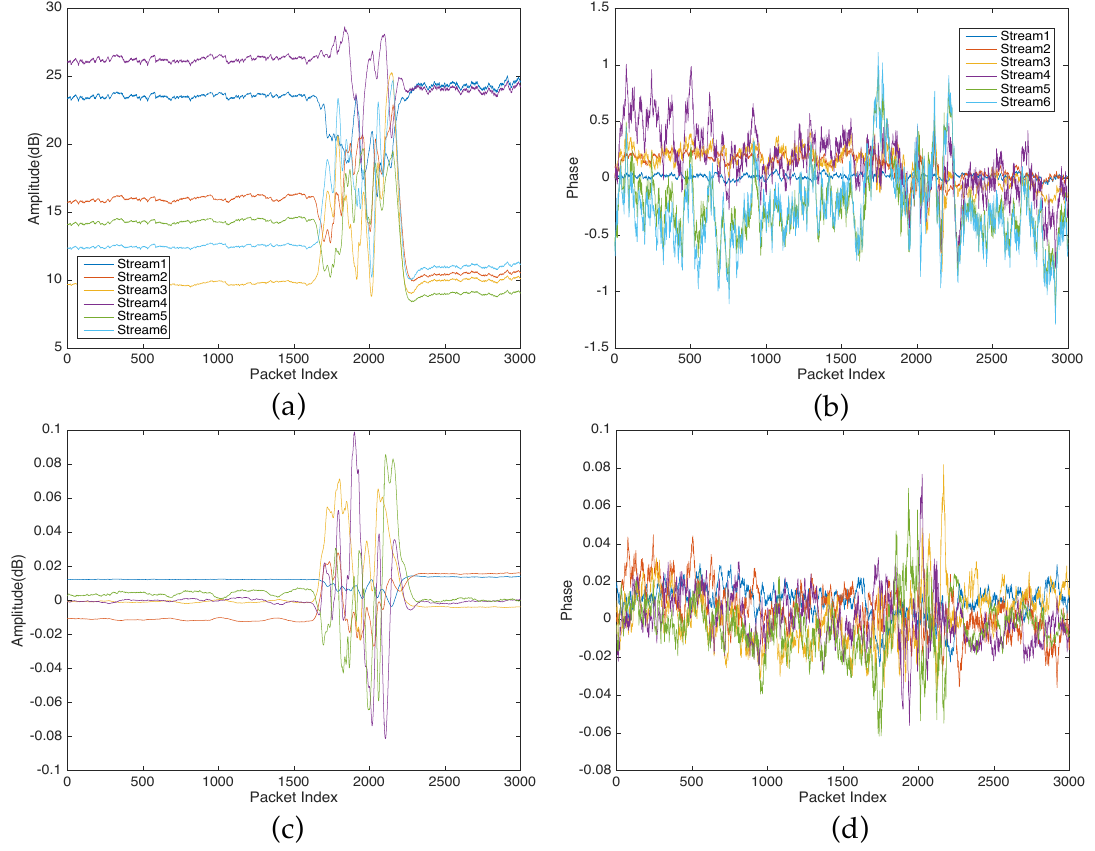
Figure 3. CSI of Walk experiments and Principle Components Analysis (PCA). ( a ) Original CSI amplitude; ( b ) Original CSI phase; ( c ) Principle Components (PCs) of CSI amplitude; ( d ) Principle Components (PCs) of CSI